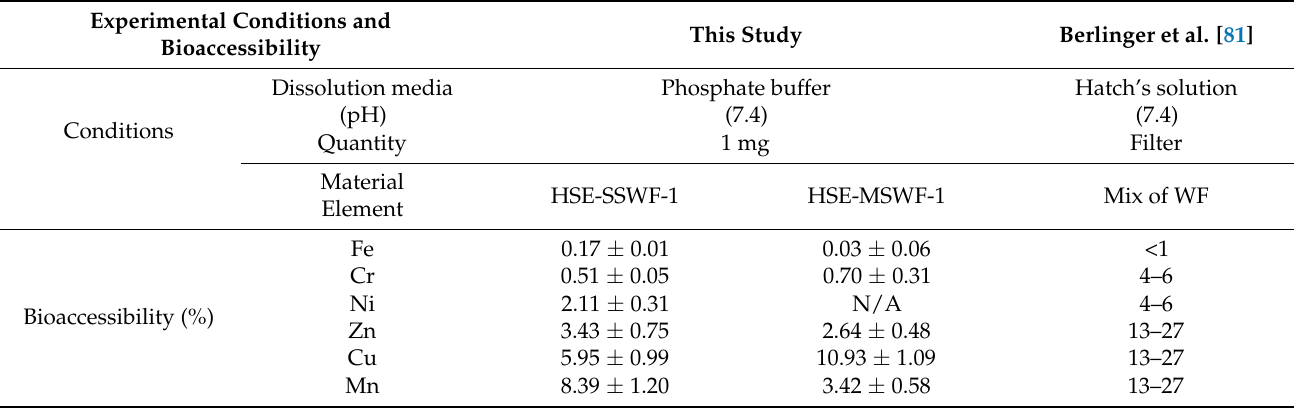
Table A6. Experimental conditions to study the bioaccessibility of welding fumes in 10 mL of extracting solutions during 24 h at 37 ◦ C.